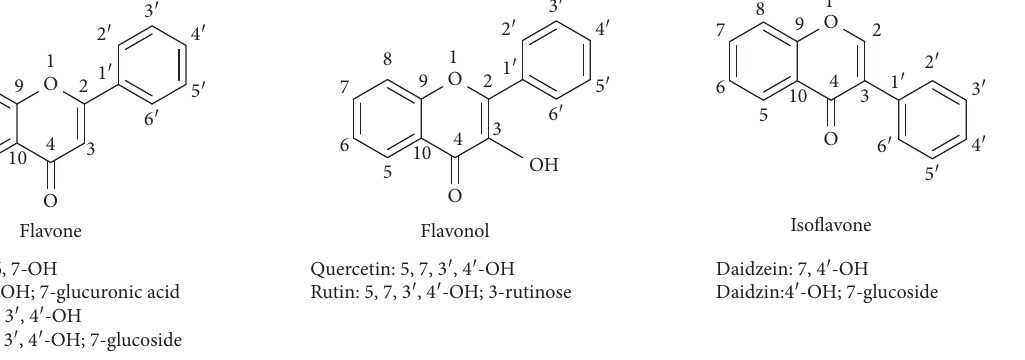
Figure 1: Chemical structures of 8